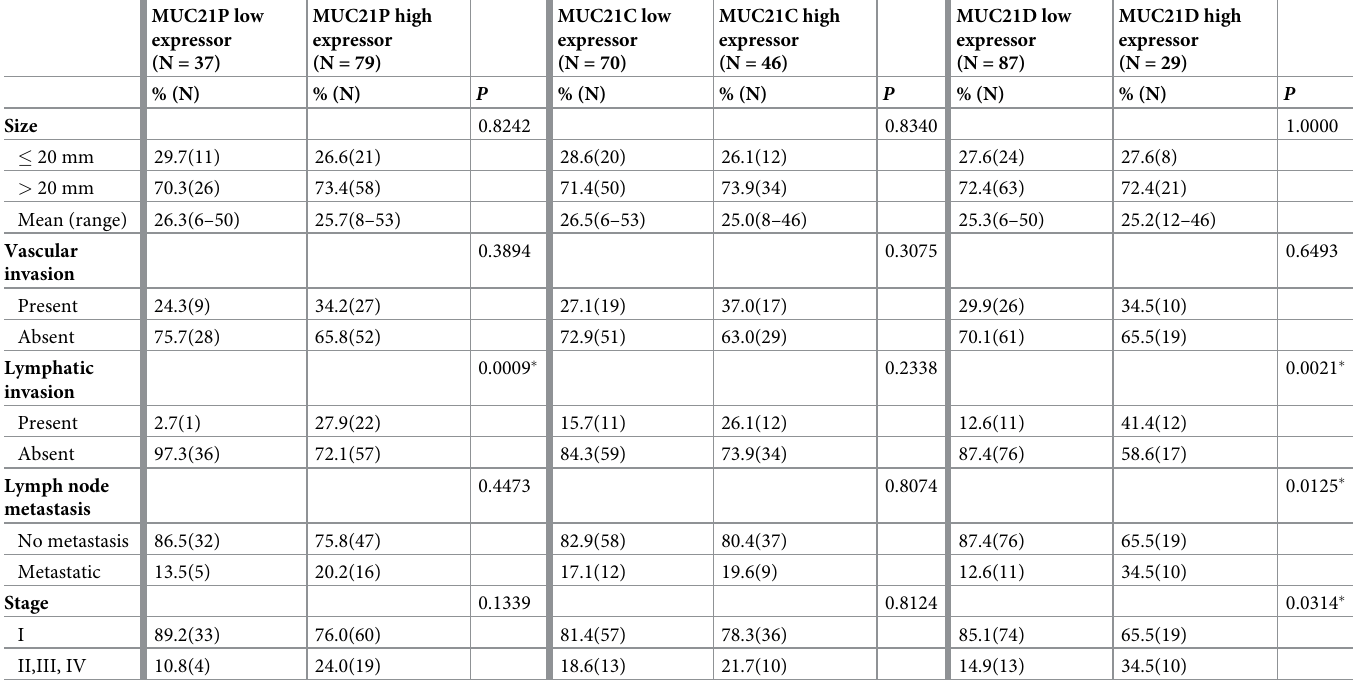
Table 2. Correlation between MUC21 expression and pathological factors in EGFR -mutated lung adenocarcinomas. MUC21P low